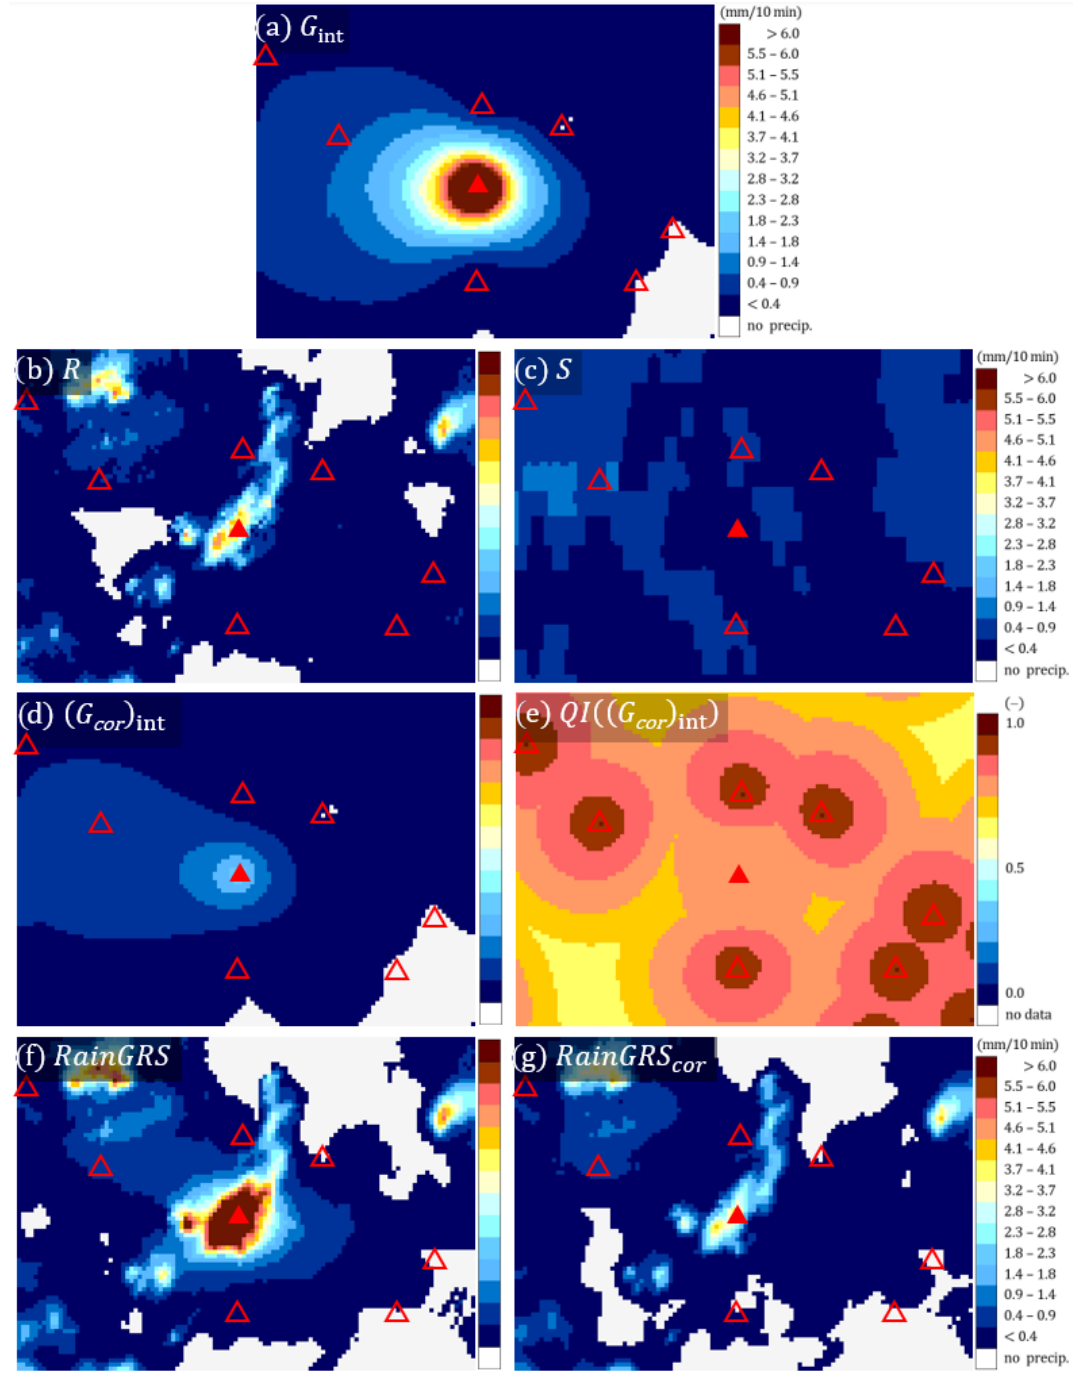
Figure 8. Various fields of 10min precipitation accumulation (in mm/10min) in the vicinity of the Nowa Wie ´ s Podgórna rain station (marked with a red triangle; the locations of other rain stations are marked with empty triangles): (a) spatially interpolated field from rain gauge data without QC ( G int ) , (b) radar-based precipitation field ( R) , (c) satellite-based precipitation field ( S) , (d) spatially interpolated field from rain gauge data after QC (cid:0) (G cor ) int (cid:1) , (e) QI field for the precipitation field from rain gauge data after QC (cid:0) QI (cid:0) (G cor ) int (cid:1)(cid:1) , (f) multi-source precipitation field (RainGRS) obtained from raw rain gauge data, and (g) multi-source precipitation field (RainGRS cor ) obtained from rain gauge data after QC. Data from 22 June 2021 at 13:30UTC for a fragment of the Polish domain (110km × 80km).